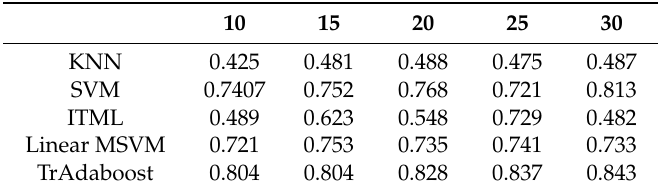
Table 7. Accuracy of test algorithms in different Tar-test sample sizes.